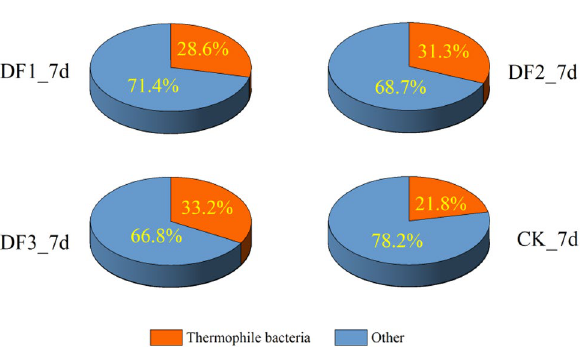
Figure 9. Percentage of thermophilic bacteria in each sample during high temperature